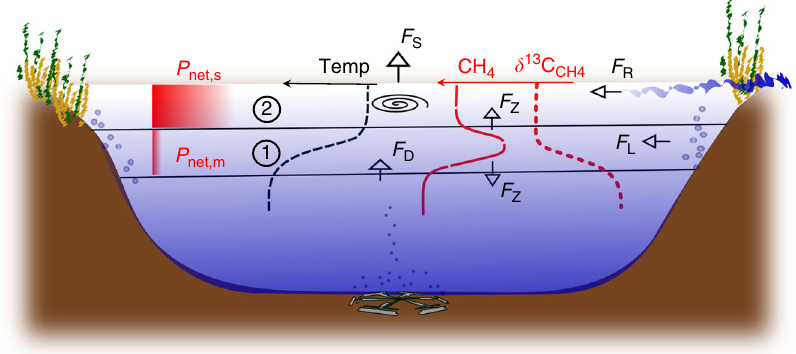
Fig. 1 Conceptual schematic of the CH 4 budget in mesotrophic Lake Hallwil. CH 4 mass balance components: evasion to the atmosphere ( F S ), interior turbulent diffusion ( F z ), transport from the aeration system ( F D ), lateral transport ( F L ), and river input rate ( F R = Q R × C R ). The case study (Lake Hallwil, Switzerland) was divided into zone 1 (metalimnion) and zone 2 (surface mixed layer). The mass balance reveals that average dissolved CH 4 concentration in the summer shows a CH 4 metalimnetic maximum concentration (zone 1), however with low production rates ( P net,m ). The highest CH 4 production rates ( P net,s ) are actually at the surface (zone 2). The turbulent gas exchange at the lake surface acts to mitigate the zone 2 CH 4 concentrations by enhancing outgassing, while the metalimnion gas exchanges are driven by turbulent